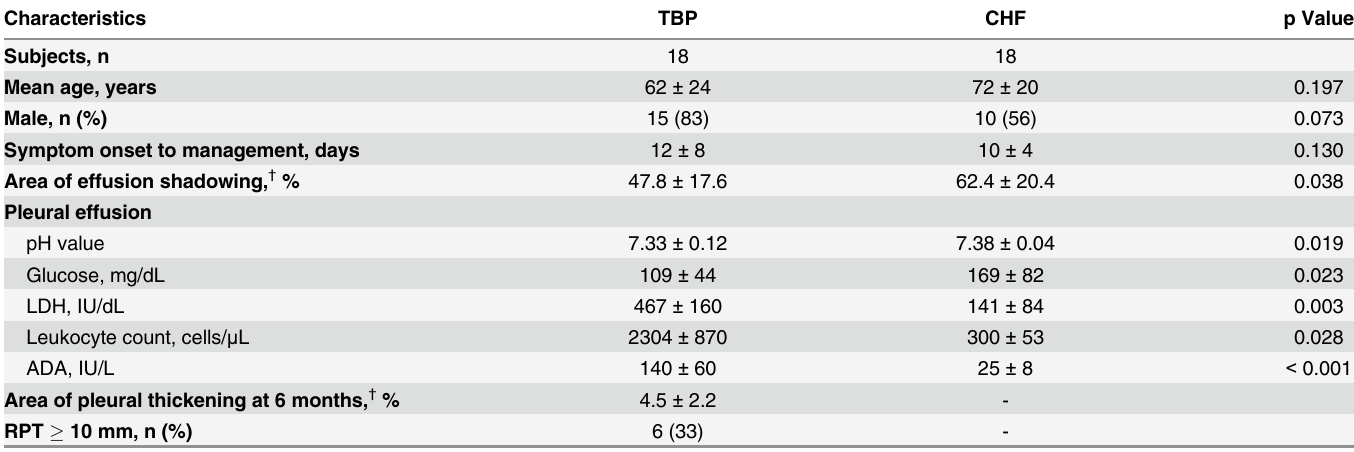
Table 1. Clinical Data and Pleural Fluid characteristics * . Definition of abbreviations : TBP, tuberculous pleuritis; CHF, congestive heart failure; LDH, lac- tate dehydrogenase; ADA, adenosine deaminase; RPT, residual pleural thickening.